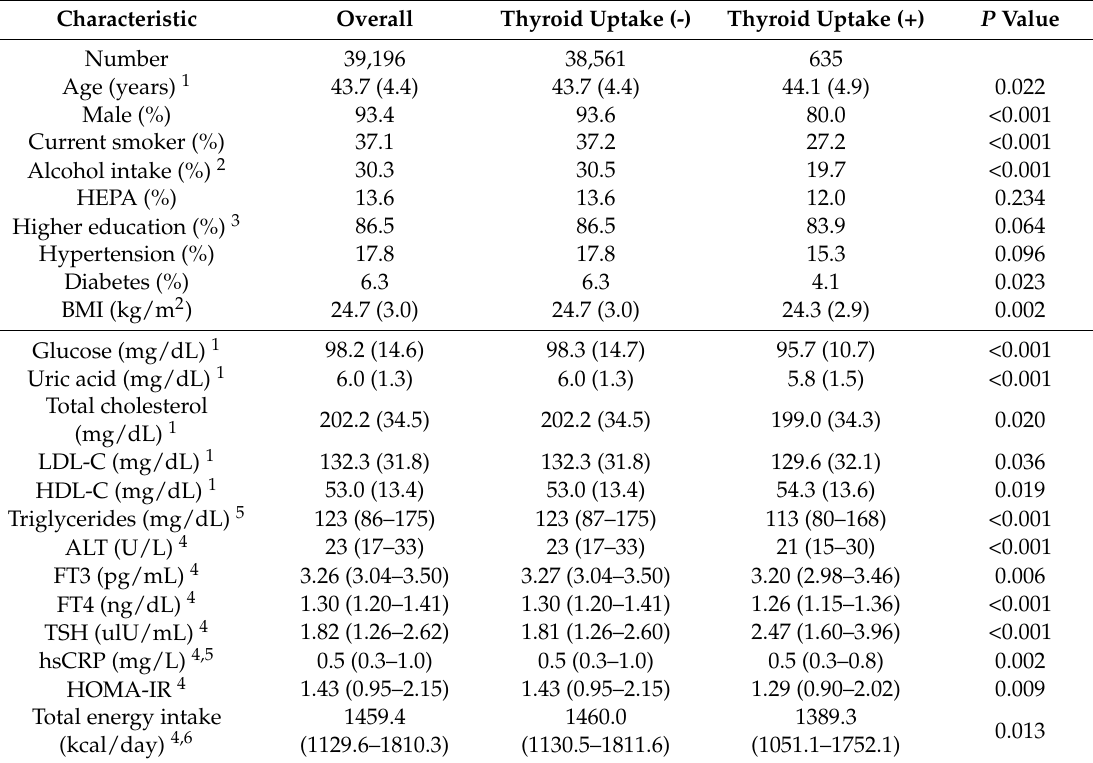
Table 1. Baseline characteristics of study participants by diffuse thyroid uptake on PET-CT. Characteristic